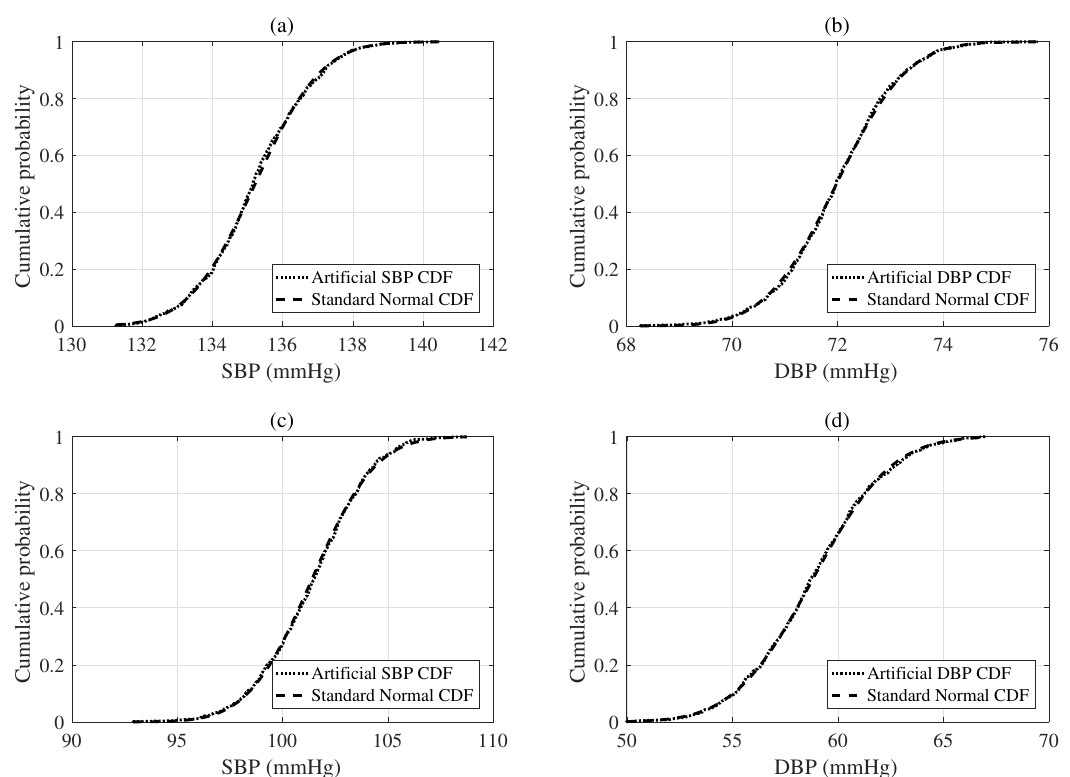
Figure 4. Cumulative distribution functions (CDFs) of selected artificial BP estimations obtained from the parametric bootstrap approach with replication numbers ( N = 100) based on the results of the deep learning regression model. Note that the upper plot ( a , b ) are the examples obtained from one subject with 5 BP estimations and the bottom plot ( c , d ) are the examples acquired from another subject with 5 BP